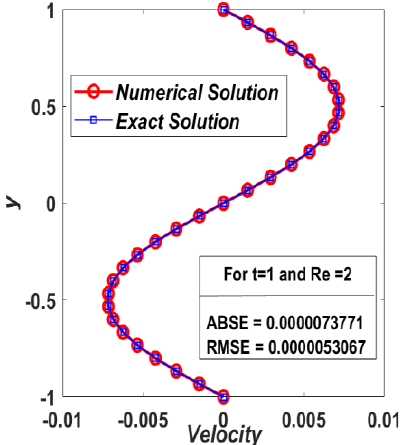
Figure 3. Comparison of present numerical result with an exact solution at t=0.5 .